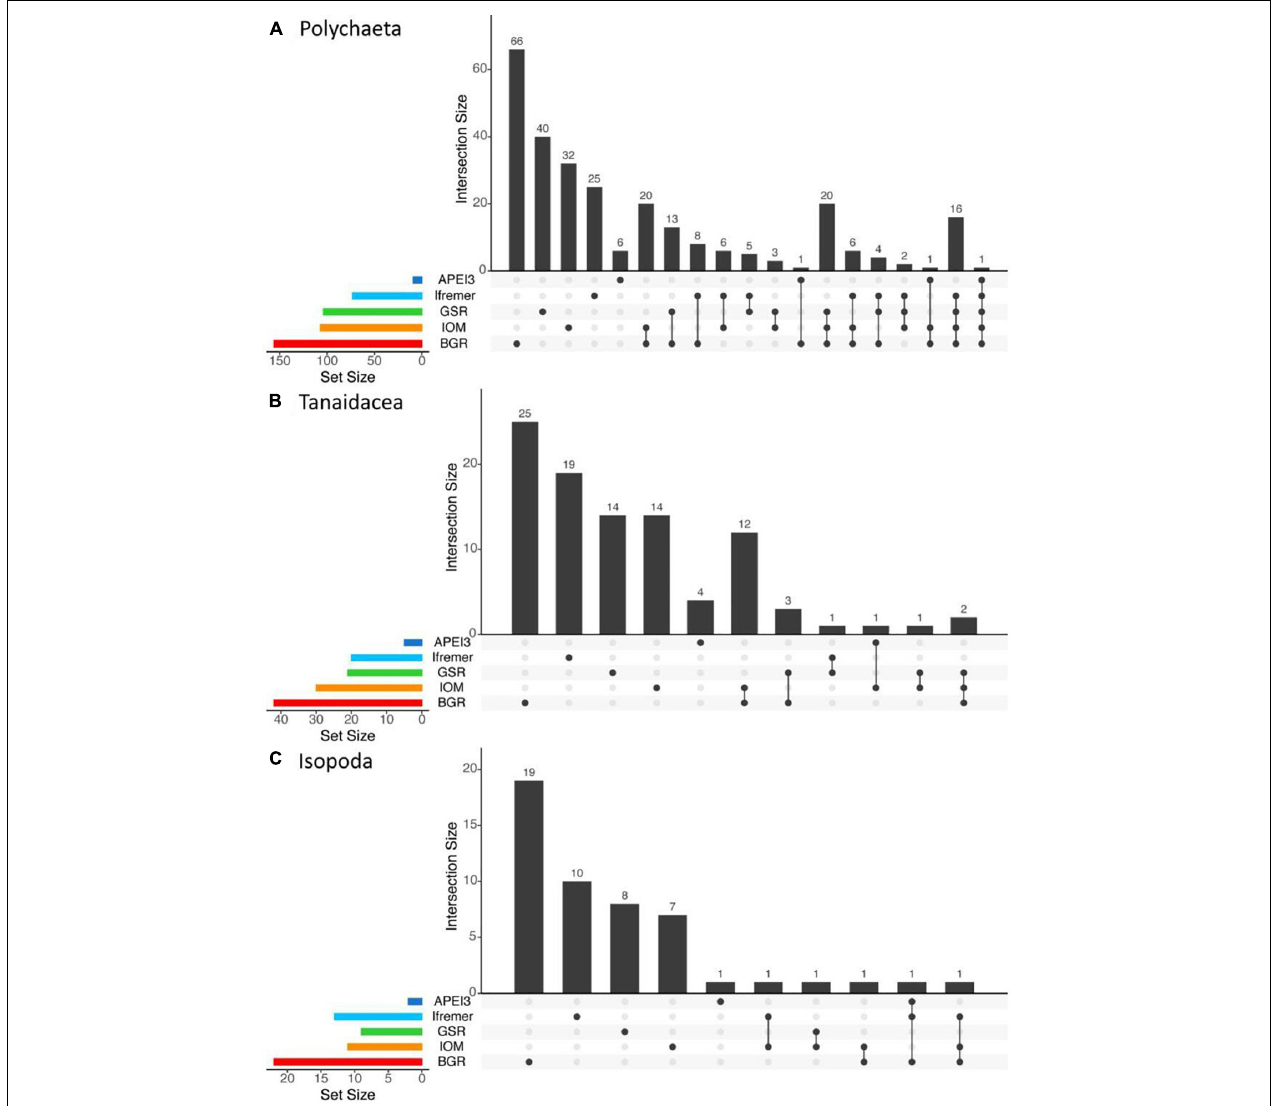
FIGURE 13 | UpSet plots showing the intersection of sediment macrofaunal species resolved by morphological and/or molecular approaches across the five JPIO sites (i.e., sites with a common species-level taxonomy) for (A) polychaetes, (B) tanaids, and (C) isopods. Vertical bars on the main plots represent the number of the unique species in each area (indicated by dots in the bottom part of the graph) or number of species shared across sites (dots connected by lines). Bars on the left are the total number of morphological species and MOTUs (Molecular Operational Taxonomic Units) identified in each of the five areas.